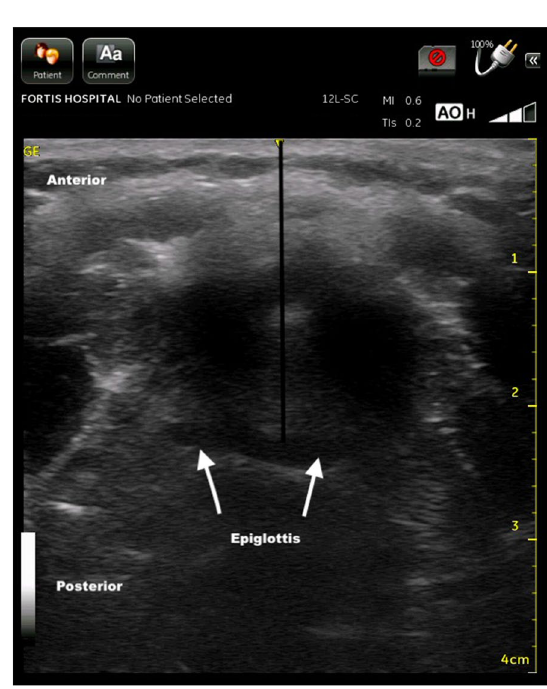
Fig. 2 Distance from anterior neck surface to epiglottis (ANS-E). Legend: Black line indicates ANS-E